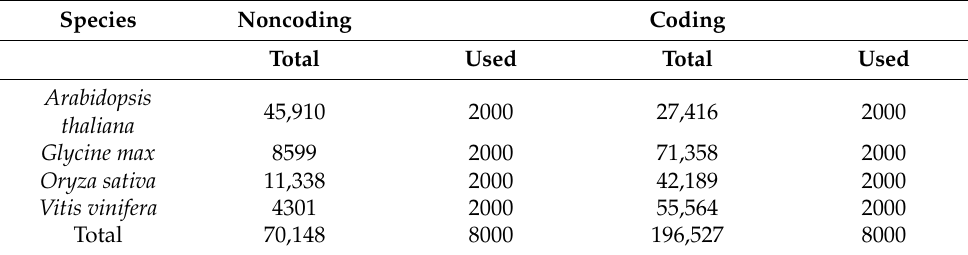
Table 4. Training set data for the model.